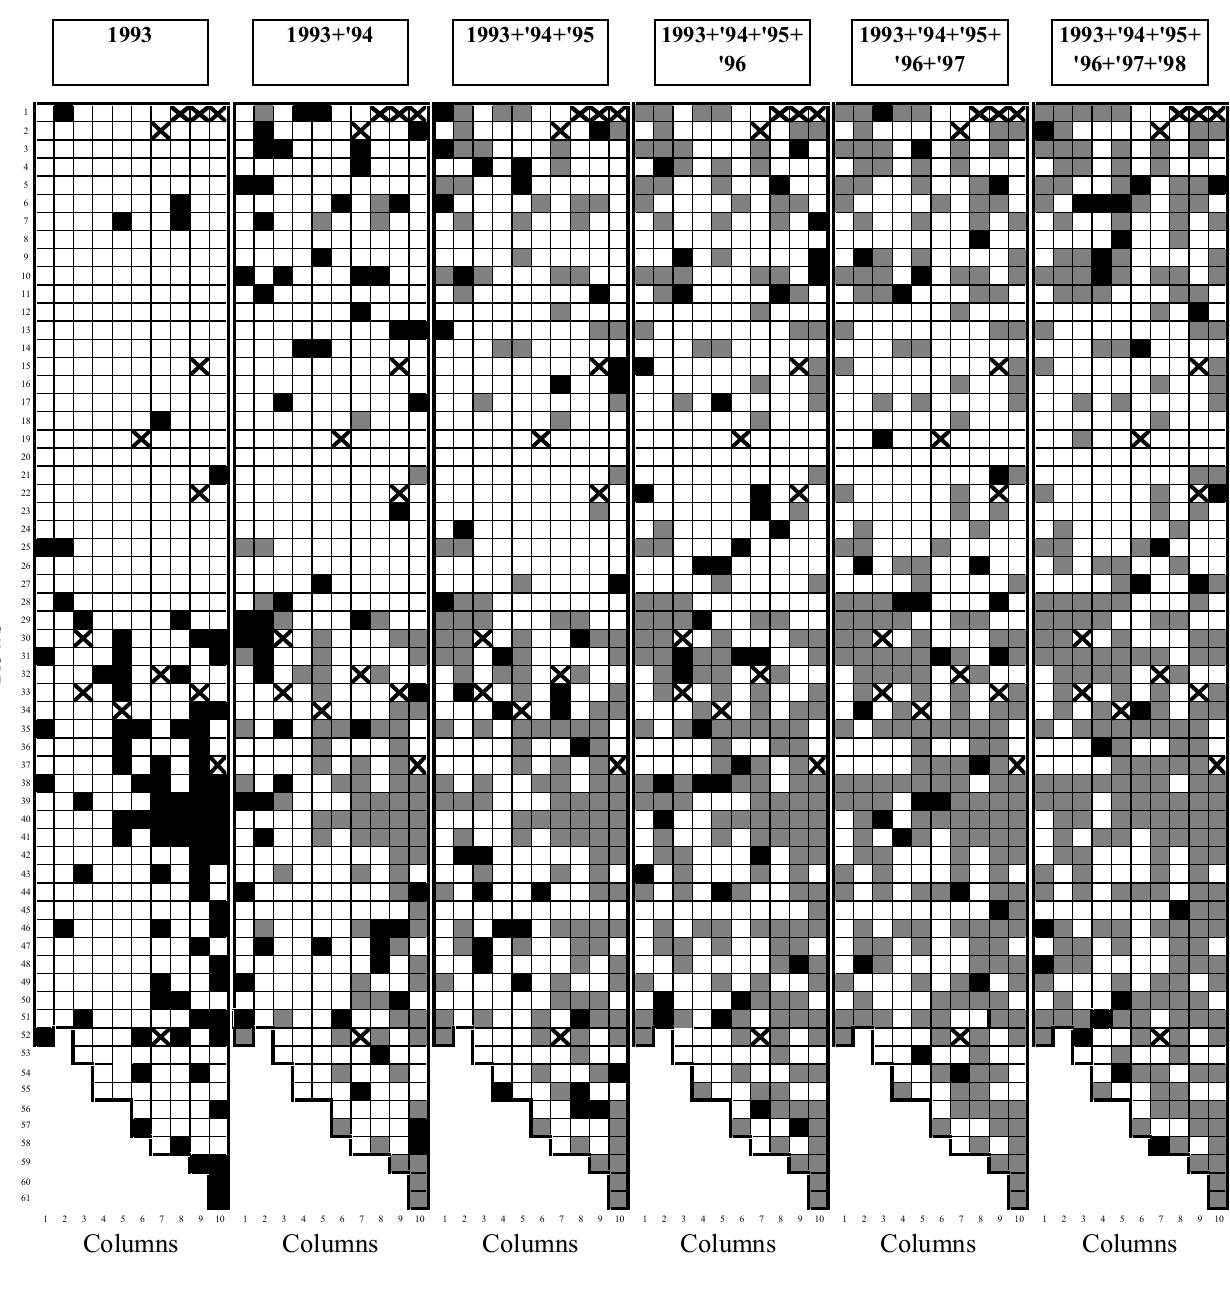
Fig. 4. Spatial pattern of esca-diseased plants in a vineyard at Gambassi Terme in the province of Florence cumulat- ed. Black squares, symptomatic plants; open squares, asymptomatic plants; gray squares, symptomatic plants in previous years, or dead; “ X ”, plants died before start of survey (cause